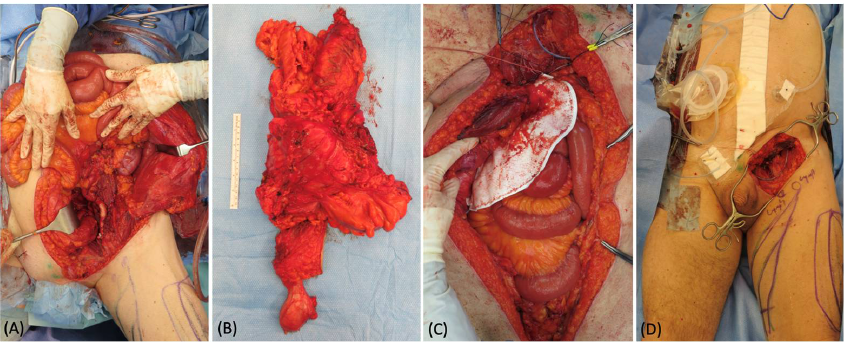
Figure 3. ( A ) Intraoperative picture of the extensive surgery for the sarcoma removal in the abdomen. ( B ) 45 × 30 cm specimen. ( C ) Abdomen reconstruction with a mesh. ( D ) Appearance of the groin defect at the end of the abdominal surgery.